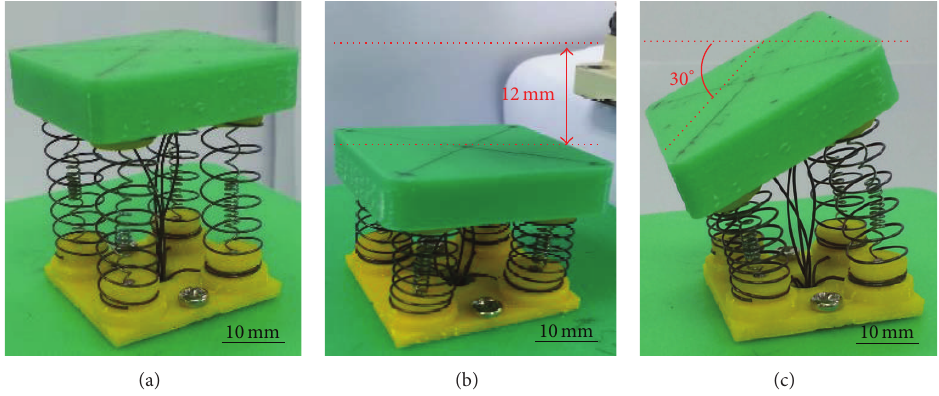
Figure 10: Prototype results: (a) initial state; (b) maximum displacement; (c) tilting angle.